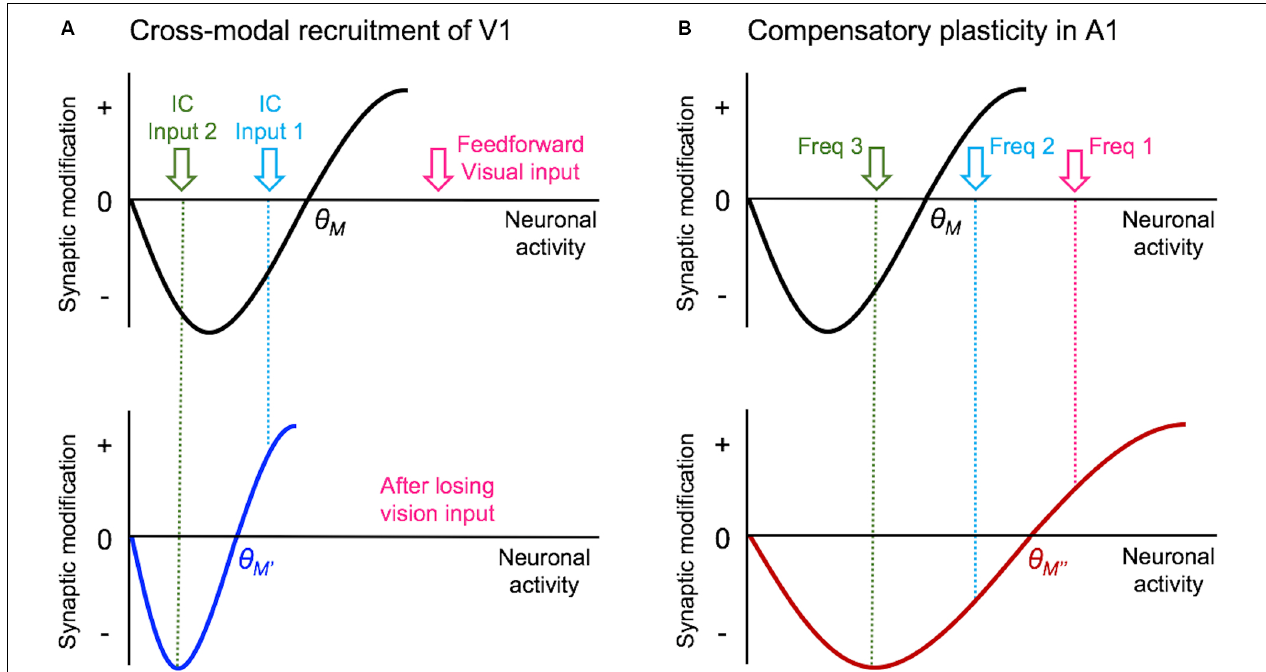
FIGURE 3 | Metaplasticity model for cross-modal synaptic plasticity induced by vision loss. The sliding threshold (or BCM) model of metaplasticity posits that the synaptic modification threshold ( θ M ) for Long-term potentiation (LTP) and Long-term depression (LTD) slides as a function of past activity (Cooper and Bear,